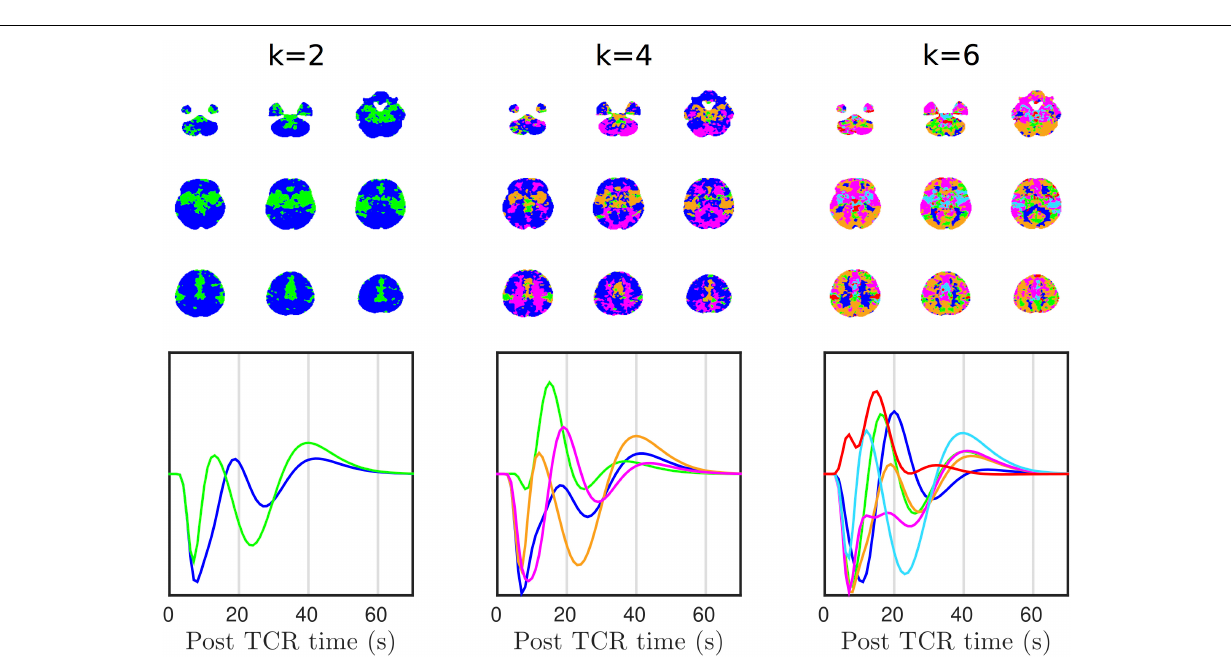
Frontiers in Neuroscience |